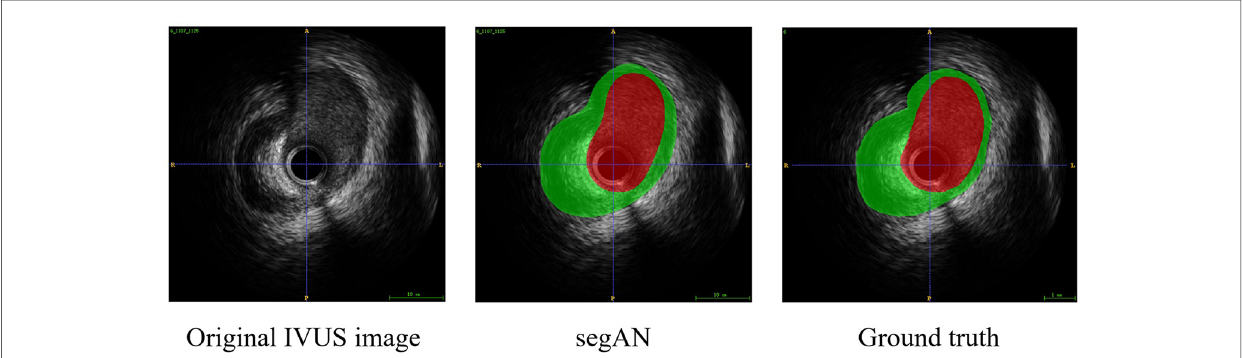
FIGURE 4 Segmentation result of SegAN compared with the Ground truth. From left to right are the original IVUS image, the segmentation result of SegAN, and the Ground truth, respectively. In the fi gure, the red region is the lumen contour and the green region is the MA contour. It can be seen that the segmentation result of SegAN is very similar to the ground truth, and the edges are